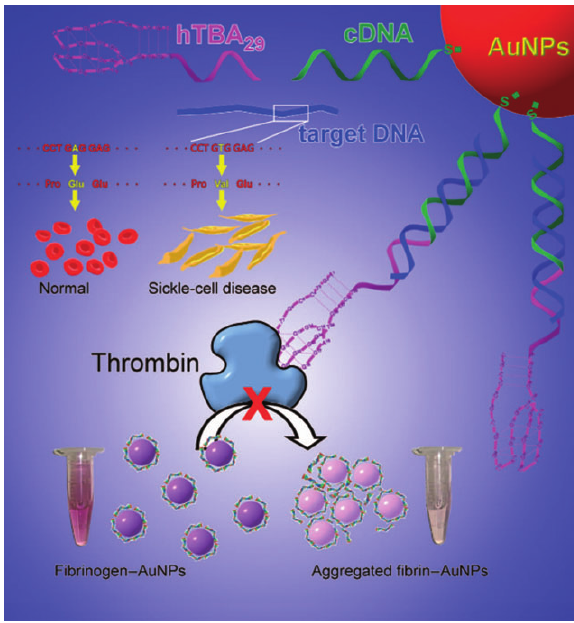
Figure 17 Schematic representation of colorimetric DNA detection based on enzymatic activity modulation. Adapted from Ref. [131]